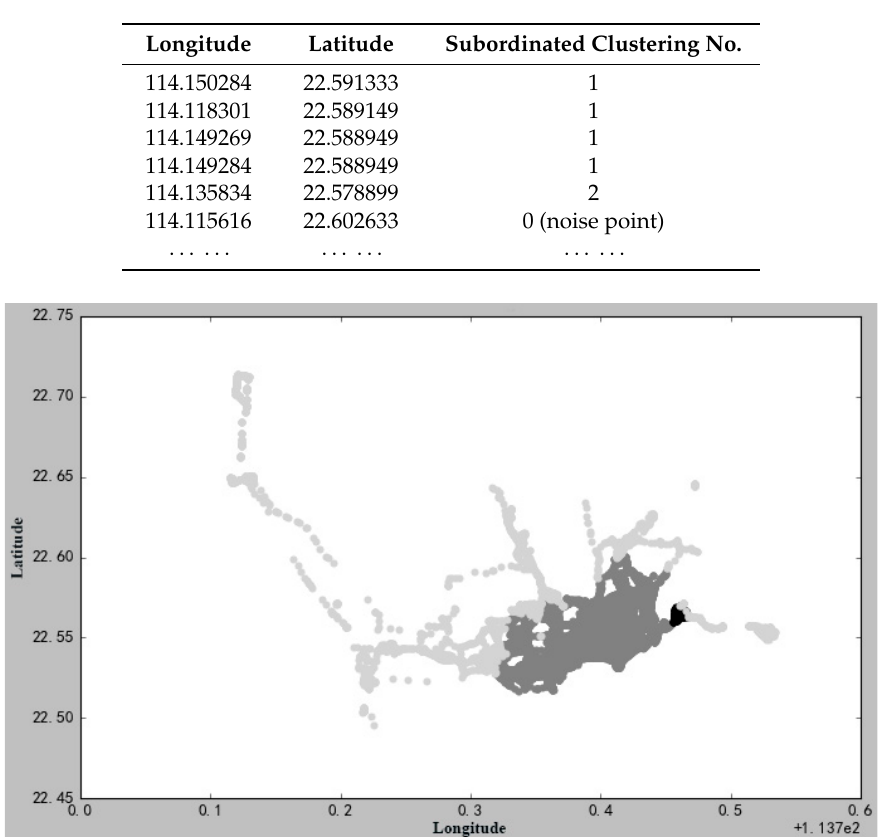
Figure 25. Visualization of the trajectory data distribution after the clustering operation.